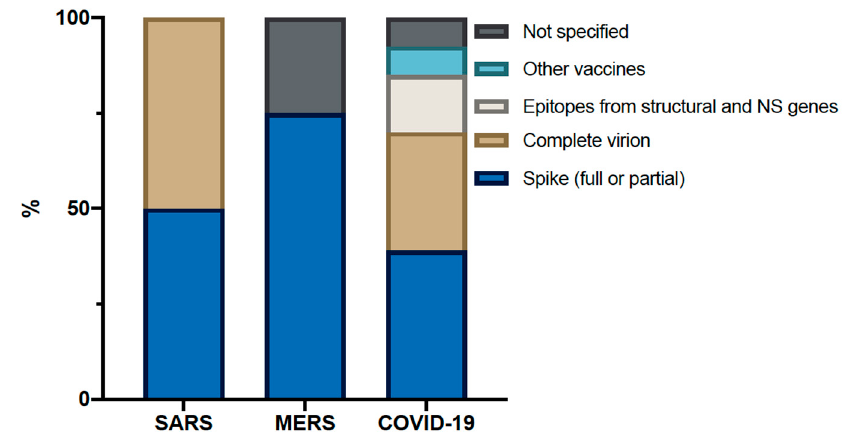
Figure 1. Types of antigens selected for the vaccine development (% of total registered active or completed clinical trials). SARS = severe acute respiratory syndrome, MERS = Middle East respiratory syndrome, COVID-19 = Coronavirus disease 2019, NS = Nonstructural